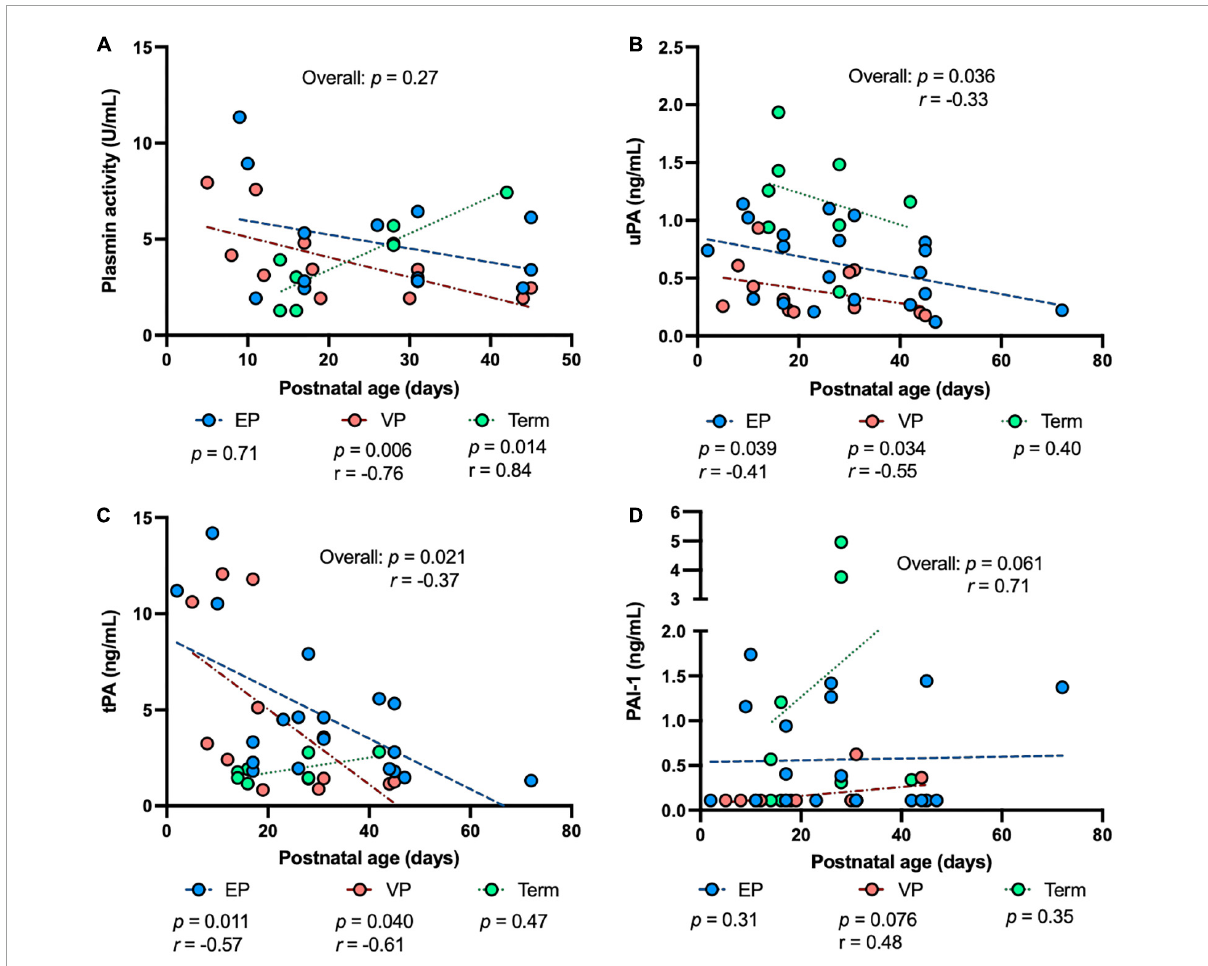
FIGURE2 The levels of plasmin system components in milk from extremely preterm-(EP), very preterm-(VP), and term-delivering mothers across postnatal age at sampling. (A) Plasmin activity across postnatal age; (B) human urokinase-type plasminogen activator (uPA) across postnatal age; (C) human tissue-type plasminogen activator (tPA) across postnatal age; (D) human plasminogen activator inhibitor type 1 (PAI-1) across postnatal age in human milk from EP ( n = 20), VP ( n = 12), term groups ( n = 8), and combined groups (overall, n = 40). r , Spearman